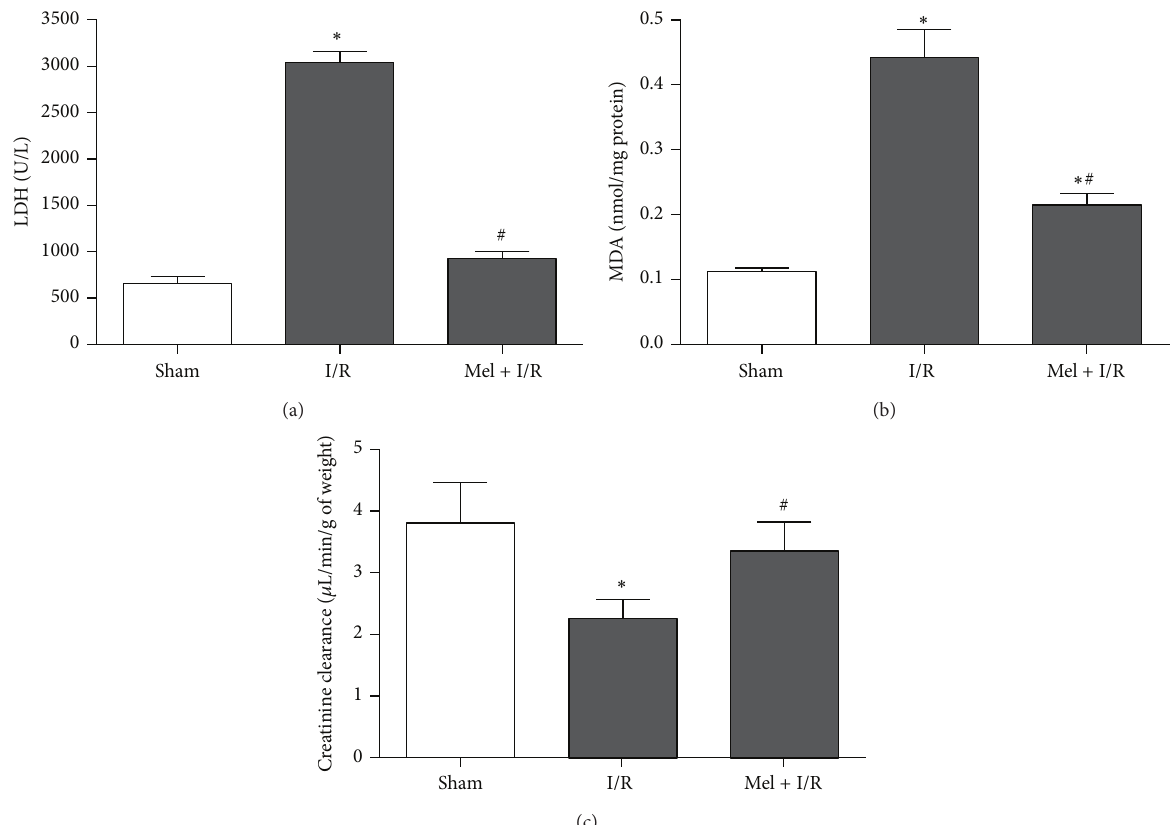
Figure 1: Evaluation of lactate dehydrogenase activity in plasma (a), malondialdehyde concentration in tissue (b), and creatinine clearance (c). Results are expressed as mean ± SEM ( 𝑛 = 6 for each group). ∗ 𝑝 < 0.05 versus Sham. # 𝑝 < 0.05 versus